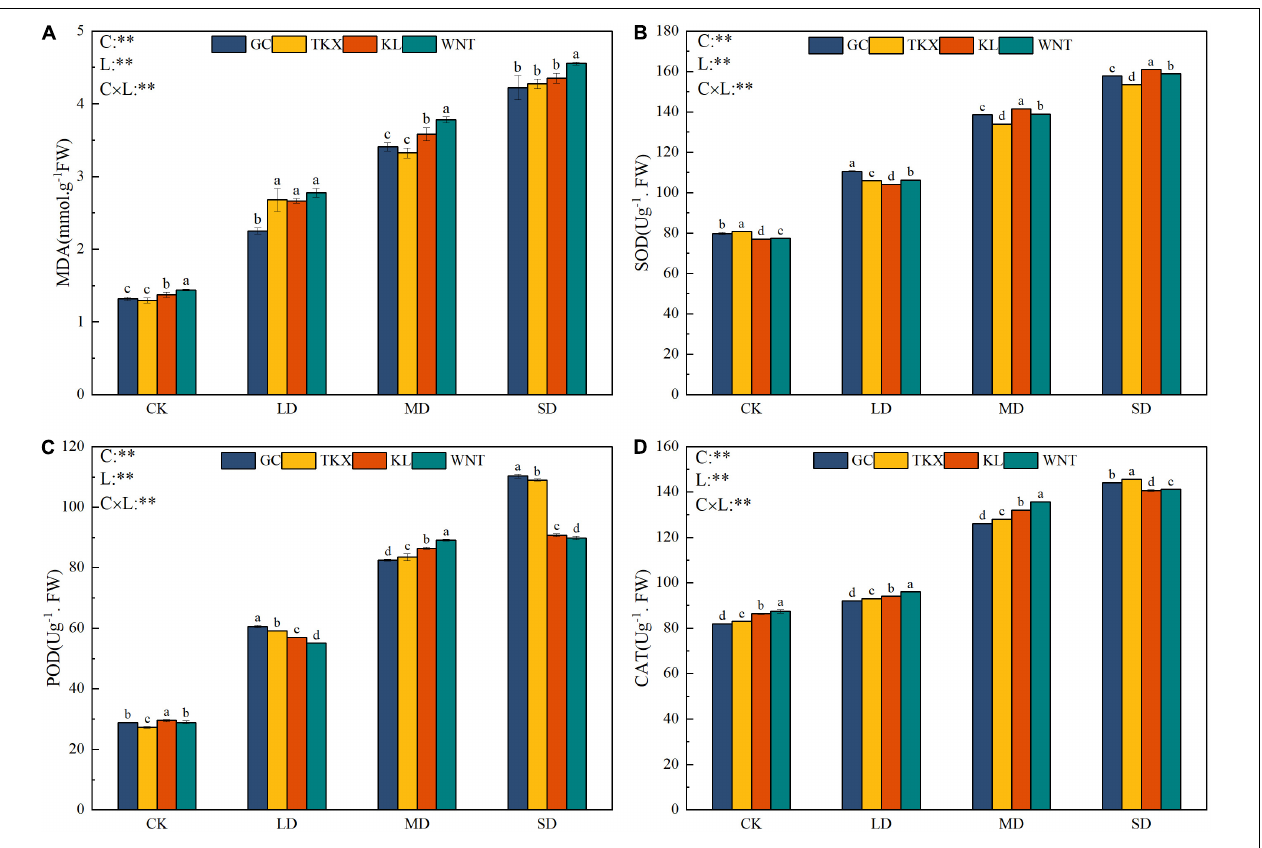
FIGURE 4 | Effects of drought stress on malondialdehyde (MDA) accumulation and antioxidant enzyme activity of different geographical populations of Solanum rostratum . Changes in MDA (A) , superoxide dismutase (SOD) (B) , peroxidase (POD) (C) , and catalase (CAT) (D) of S. rostratum under different drought-stress concentrations. The blue column represents the GC site, yellow column represents the TKX site, red column represents to KL site, and green column represents the WNT site. Different lowercase letters indicate a significant difference under drought stress in S. rostratum populations, according to Duncan’s test ( α = 0.05). C refers to the differences among drought-stress concentrations; L refers to the differences among each geographical population; C × L refers to the interaction between populations and concentration. The significant change in functional traits between the four collection sites was shown by the significance of population–stress treatment interactions. Asterisks indicate a significant difference (*, p ≤ 0.05; **, p ≤ 0.01; ***, p ≤ 0.001). Refer to statistics in Supplementary Table 1